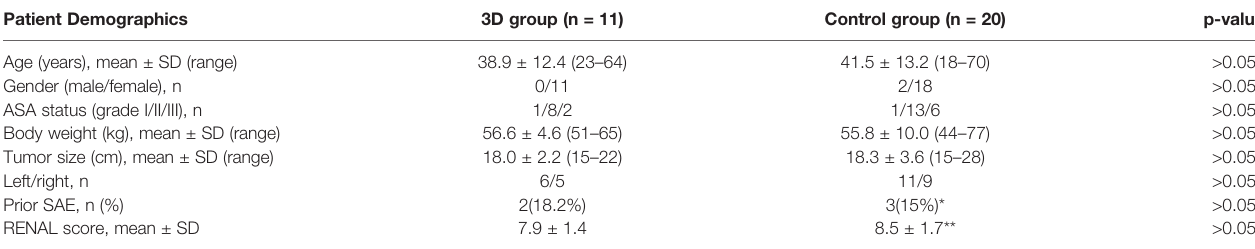
TABLE 1 | Baseline demographic and clinical characteristics.